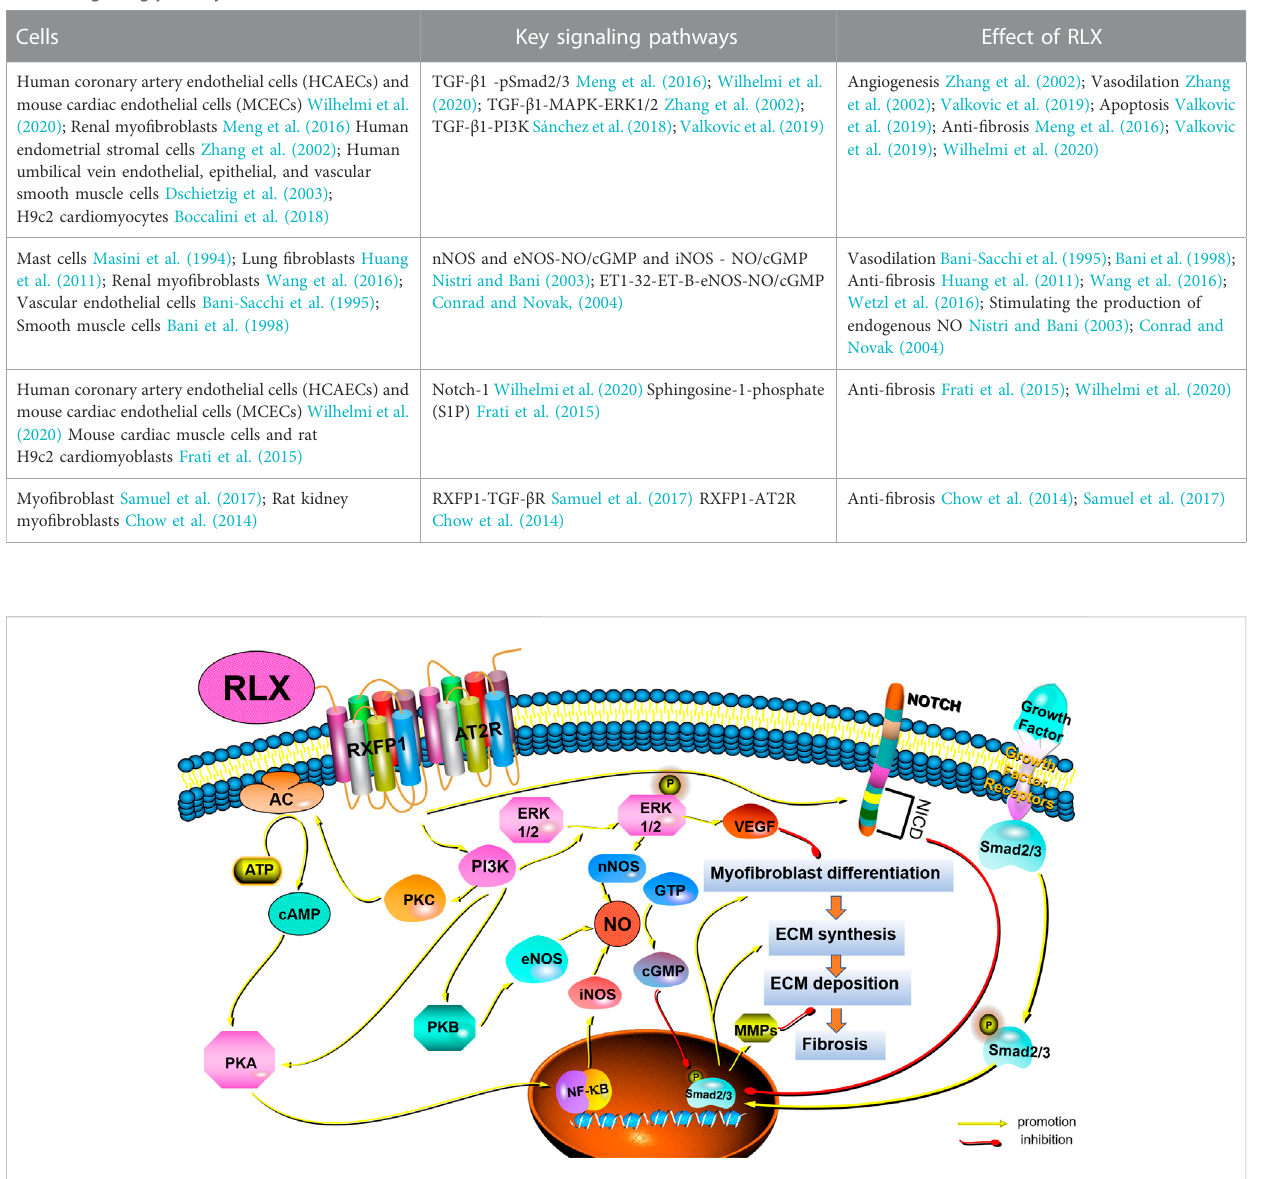
Frontiers in Cell and Developmental